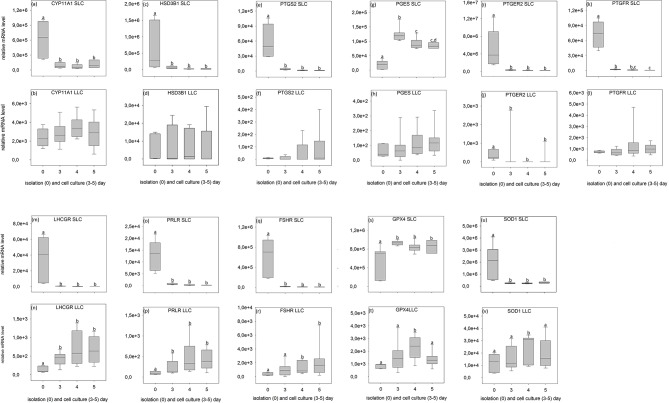
Relative mRNA level of analyzed genes in SLC (small luteal cells) and LLC (large luteal cells) obtained directly after isolation (Day 0) and after 3–5 days of culture (Experiment B). (a,b)
CYP11A1, Cholesterol Side-Chain Cleavage Enzyme, (c,d)
HSD3B1, 3β-hydroxysteroid dehydrogenase type 1, (e,f)
PTGS2, prostaglandin-endoperoxide Synthase 2, (g,h)
PGES, Prostaglandin E synthase, (i,j)
PTGER2, prostaglandin E receptor 2, (k,l)
PTGFR, prostaglandin F receptor, (m,n)
LHCGR, luteinizing hormone/choriogonadotropin receptor, (o,p)
PRLR, prolactin receptor, (q,r)
FSHR, follicle stimulating hormone receptor, (s,t)
GPX4, glutathione peroxidase 4, (u,v)
SOD1, superoxide dismutase 1. Small letters indicate significant differences between groups, based on pairwise comparison Wilcoxon rank sum test.